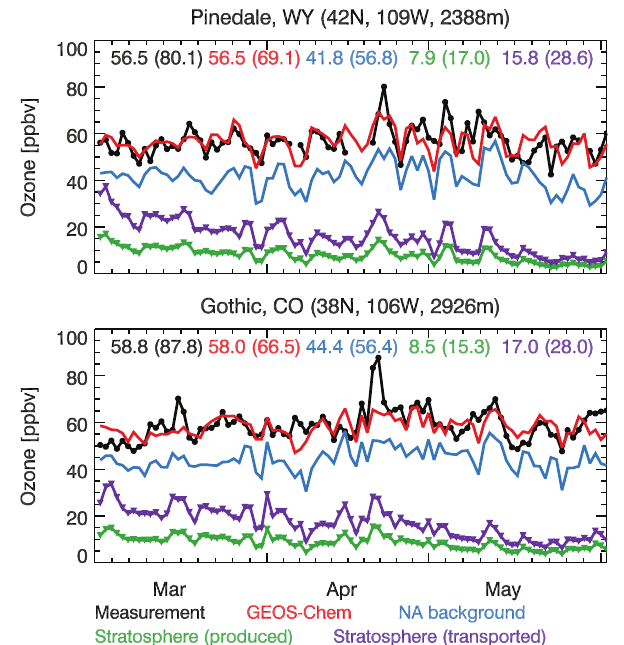
Figure 11. Time series of MDA8 ozone concentrations at Pinedale, Wyoming, and Gothic, Colorado, in spring 2006. Model results (red line) are compared with measurements (black line). Also shown are the North American background (blue line), the stratospheric ozone contributions estimated as ozone produced in the stratosphere following Zhang et al. (2011) (green line), and those estimated as ozone transported across the tropopause following Lin et al. (2012) (purple line). The mean (maximum) values for the time period are shown